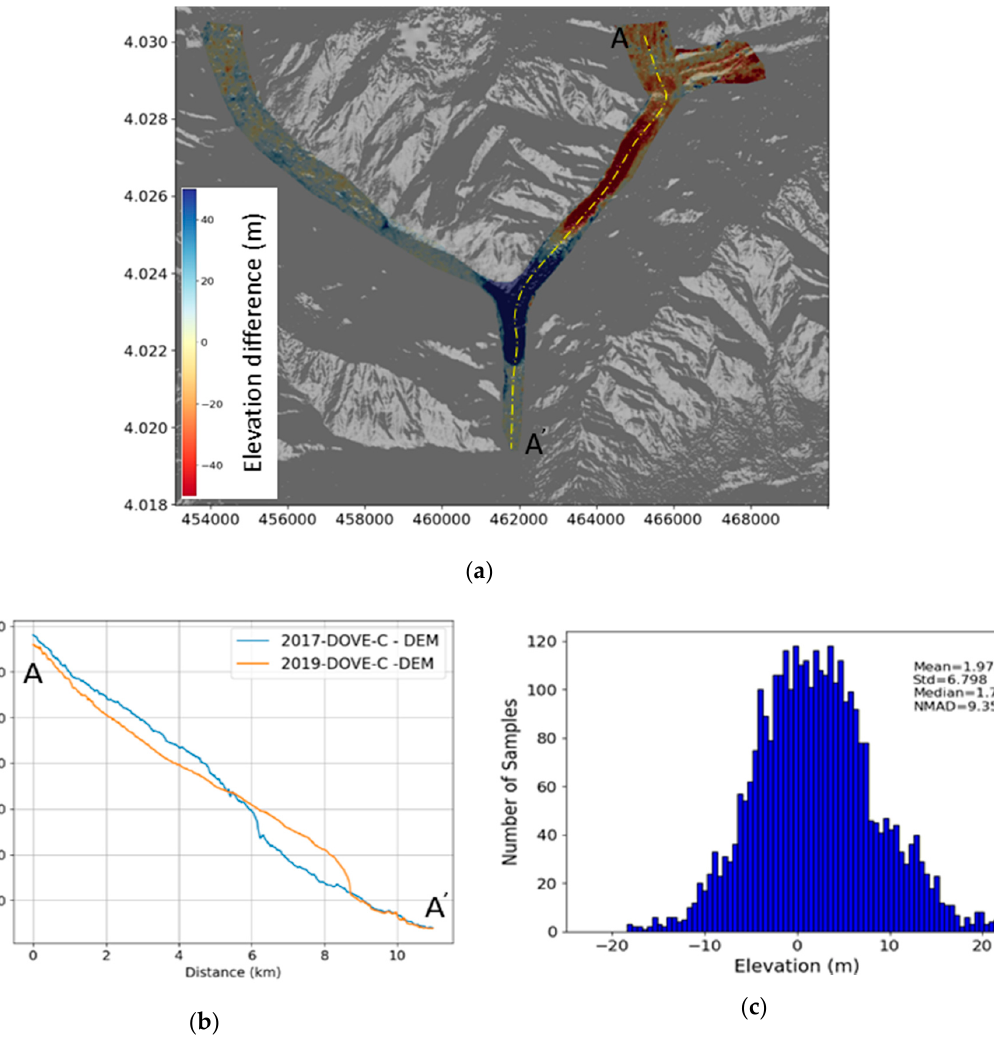
Figure 14. ( a ) Elevation changes over Shisper glacier computed from the difference of 2019 and 2017 DOVE-C DEMs, overlaid with a hill-shaded DOVE-C 2017 DEM; ( b ) Elevation profiles from 2017 and 2019 Dove-C DEMs. Profiles are extracted along the transect AA’ indicated in panel ( a ); ( c ) histogram of the elevation di ff erence over stable